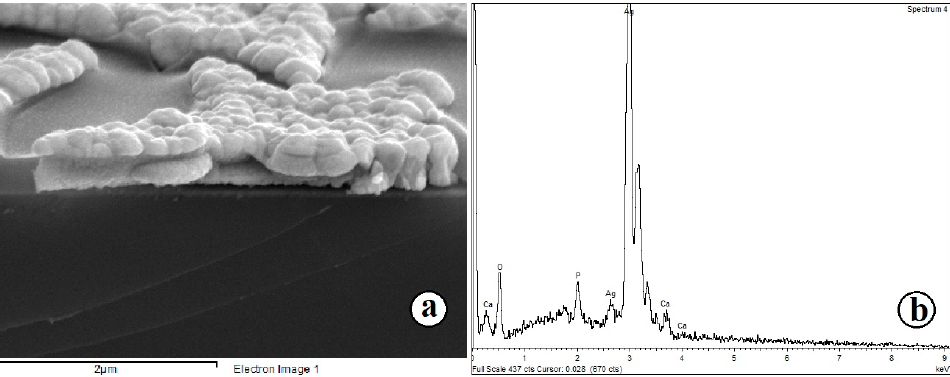
2 /Ag/HAp composite.